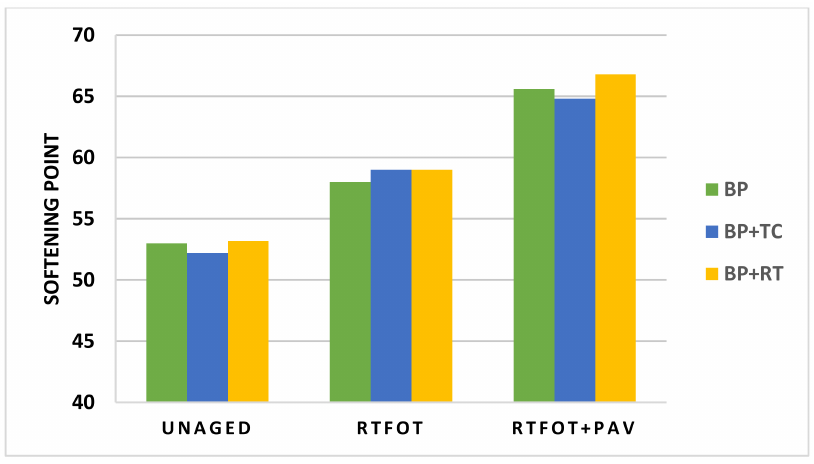
Figure 5. Softening point test results of all the samples at different ageing